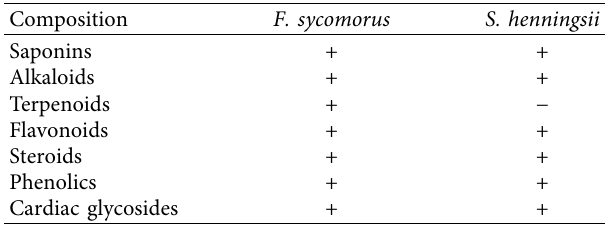
Table 1: Phytochemical screening of DCM leaf extracts of S. henningsii and stem bark of F.